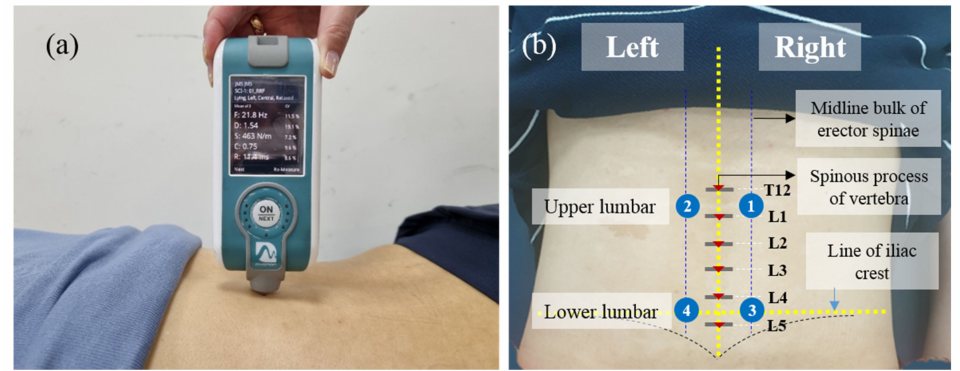
Figure 3. A photograph of the measurement using a myotonometer ( a ) and a schematic of the selection criteria for the four measurement sites of the lumbar ( b